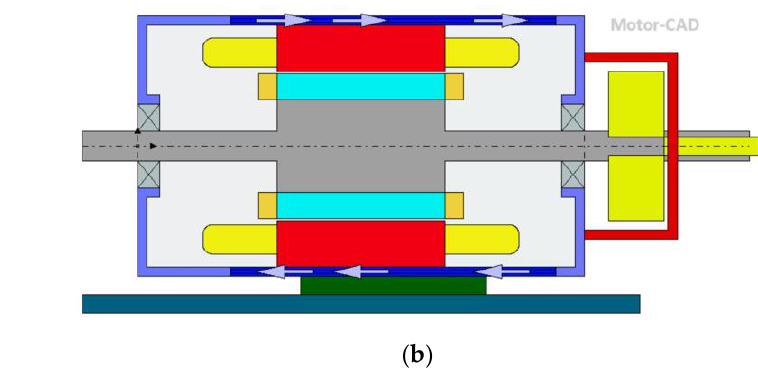
Figure 10. Radial view ( a ) and axial view ( b ) of water-cooled motor with aluminum casing (Alloy 195 cast) water-cooled motor.